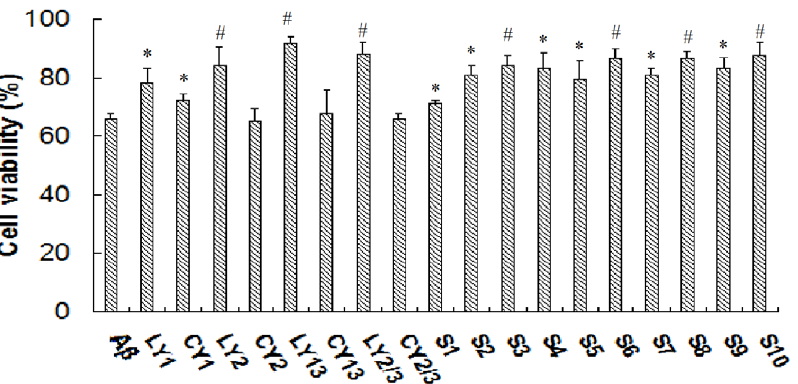
Figure 3. Effect of original and chimeric peptides on A b cytotoxicity. Ten m M of A b 42 with and without original and chimeric peptides was incubated at 37 u C for 2 h. The samples were added to wells coated with SH-SY5Y cells with the final concentration of A b 42 and peptides being 1 m M and 5 m M, respectively. After two additional days of incubation, the viability of the cells was measured using the MTT assay. The absorbance of the dissolved crystals was measured at 560 nm. Data shown were expressed as the percentage of control values (compared with control, *, P , 0.05; # , P , 0.01).